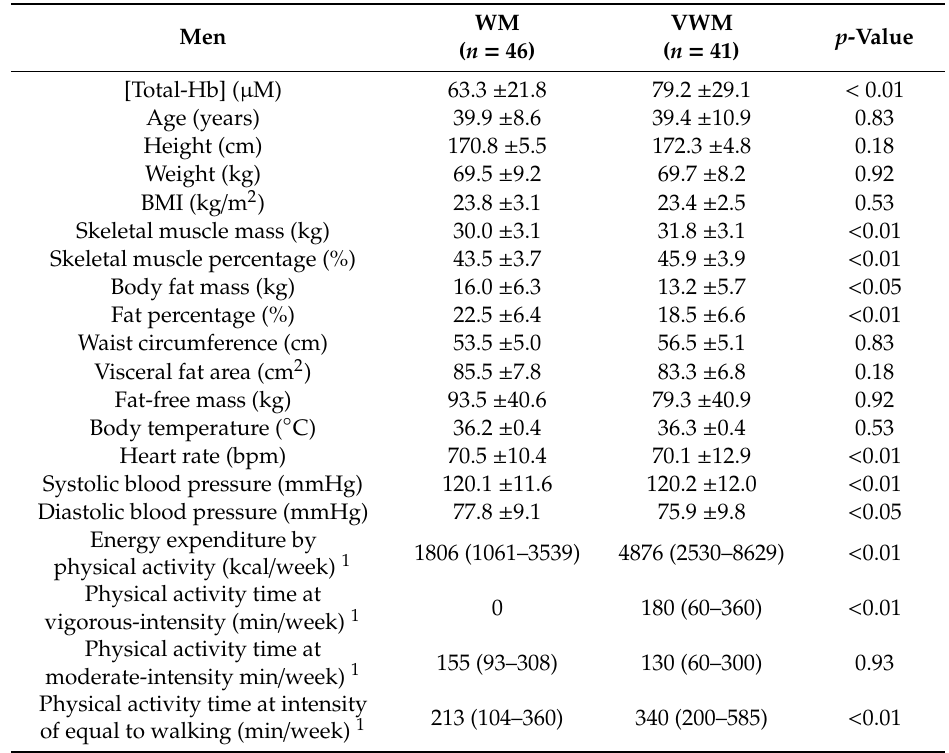
Table 3. Group comparison of each parameter in